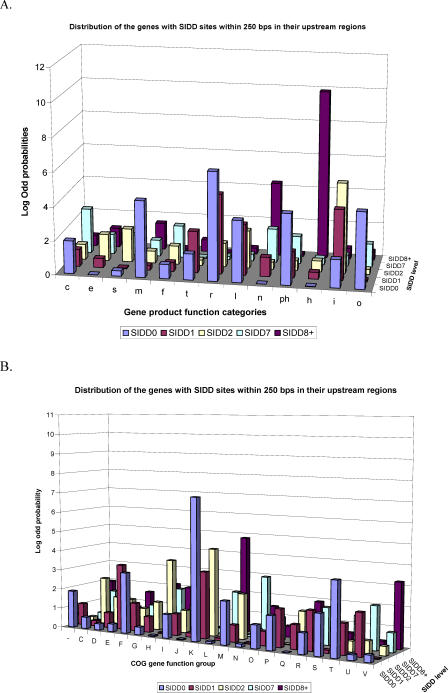
The Statistical Significances of the Associations of Genes in Functional Categories with the Extent of Destabilization in Their Upstream Flanks(A) GenProtEC functional categories; (B) COG classifications. In both cases, the immediate upstream 250-bp regions are used. Figures for the other two definitions of 5′ flanks are similar, and are given in Datasets S1 and S2.